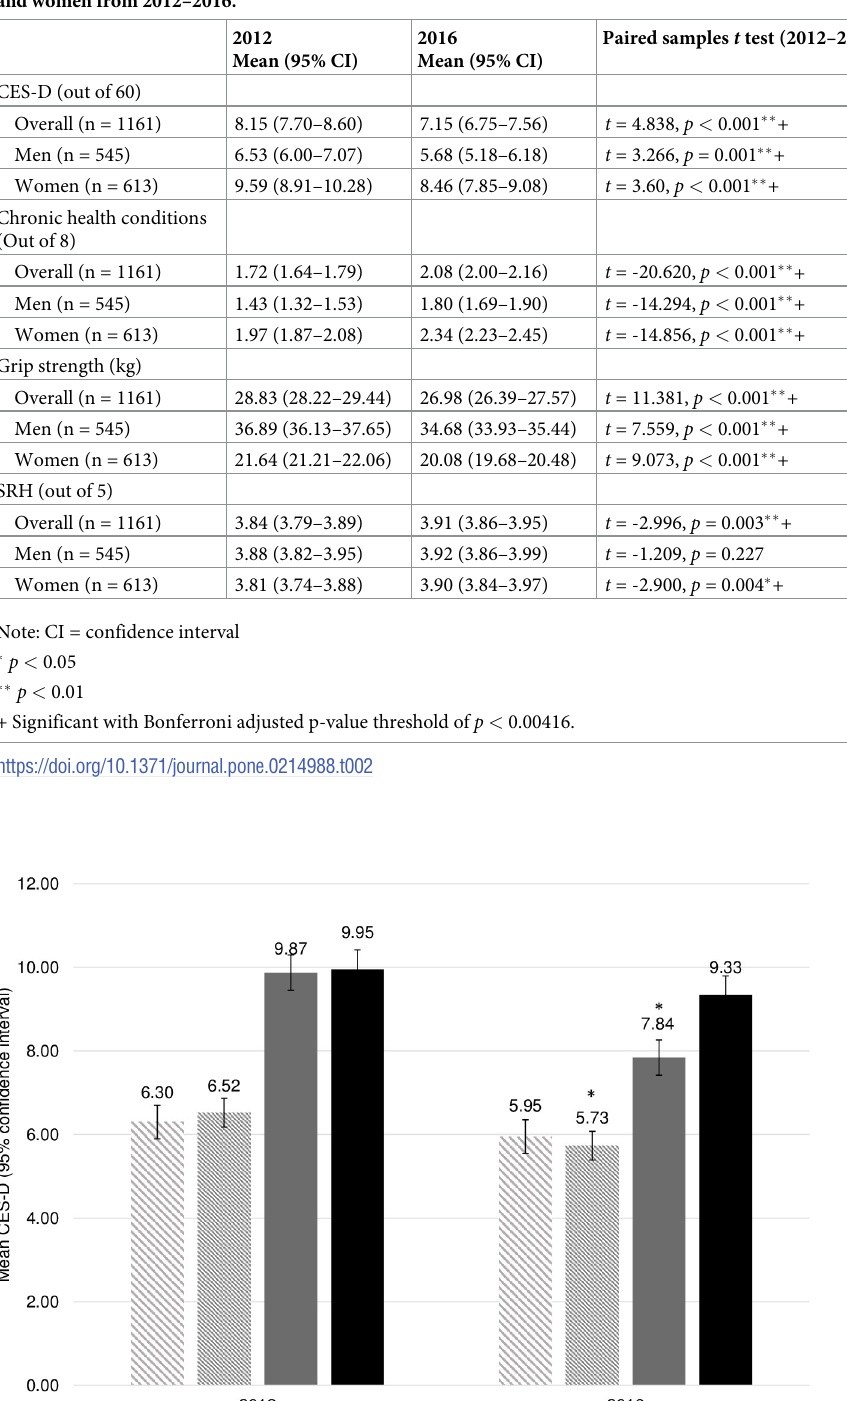
Table 2. Descriptive data: CES-D scores, chronic health conditions, grip strength, and self-rated health for men and women from 2012–2016.